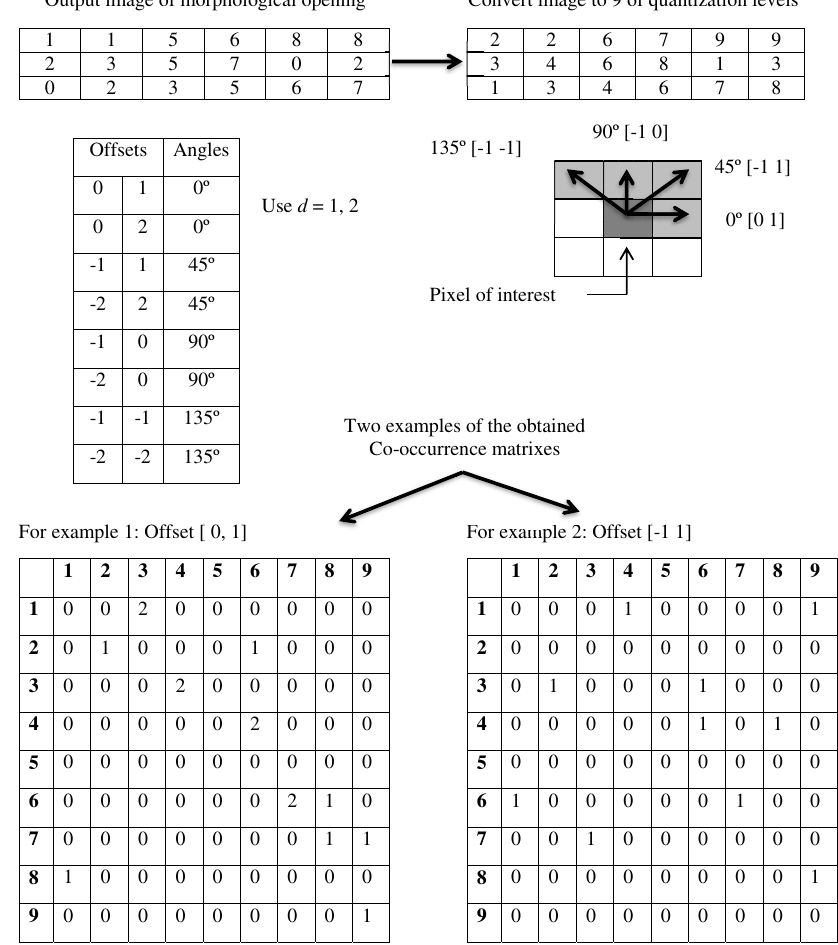
Fig. 4. How the GLCM works in the output images of morphological opening